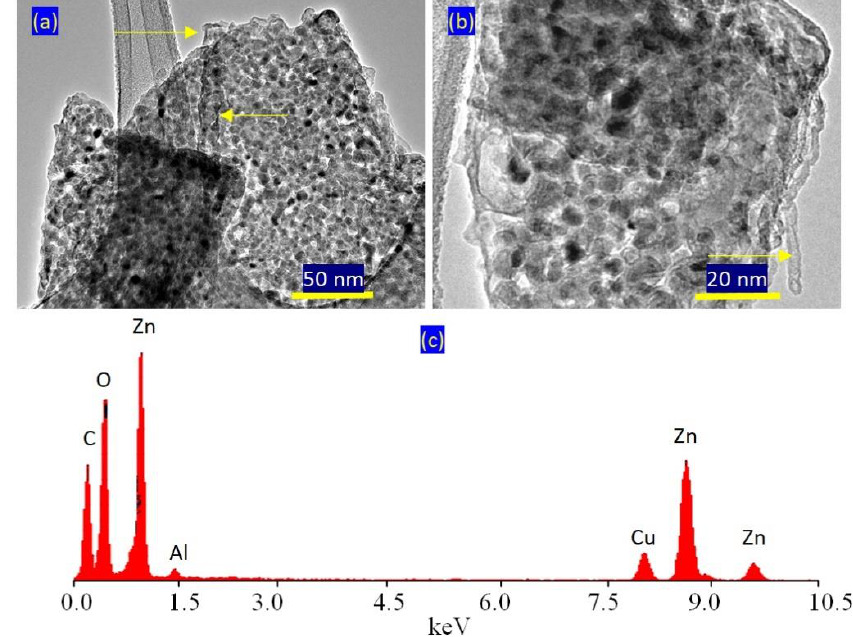
Figure 6. The AZ-2 sample: ( a ) TEM image at 50 nm, ( b ) TEM image at 20 nm and ( c ) EDX spectrum.